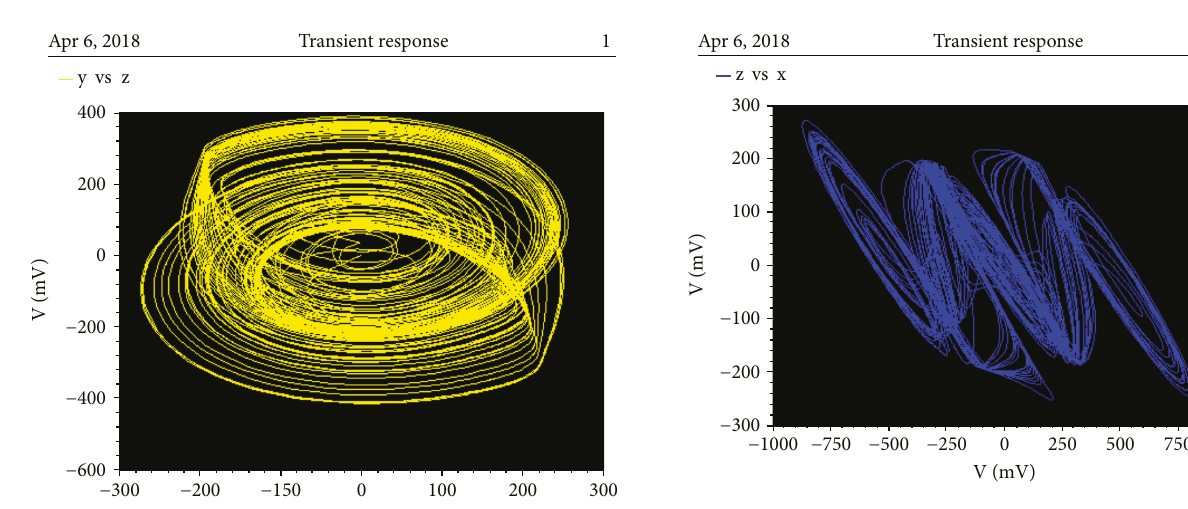
and S are turned 1 3